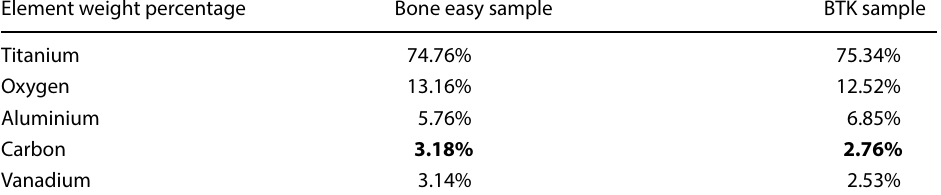
Table 3 Element weight percentage on the two examined